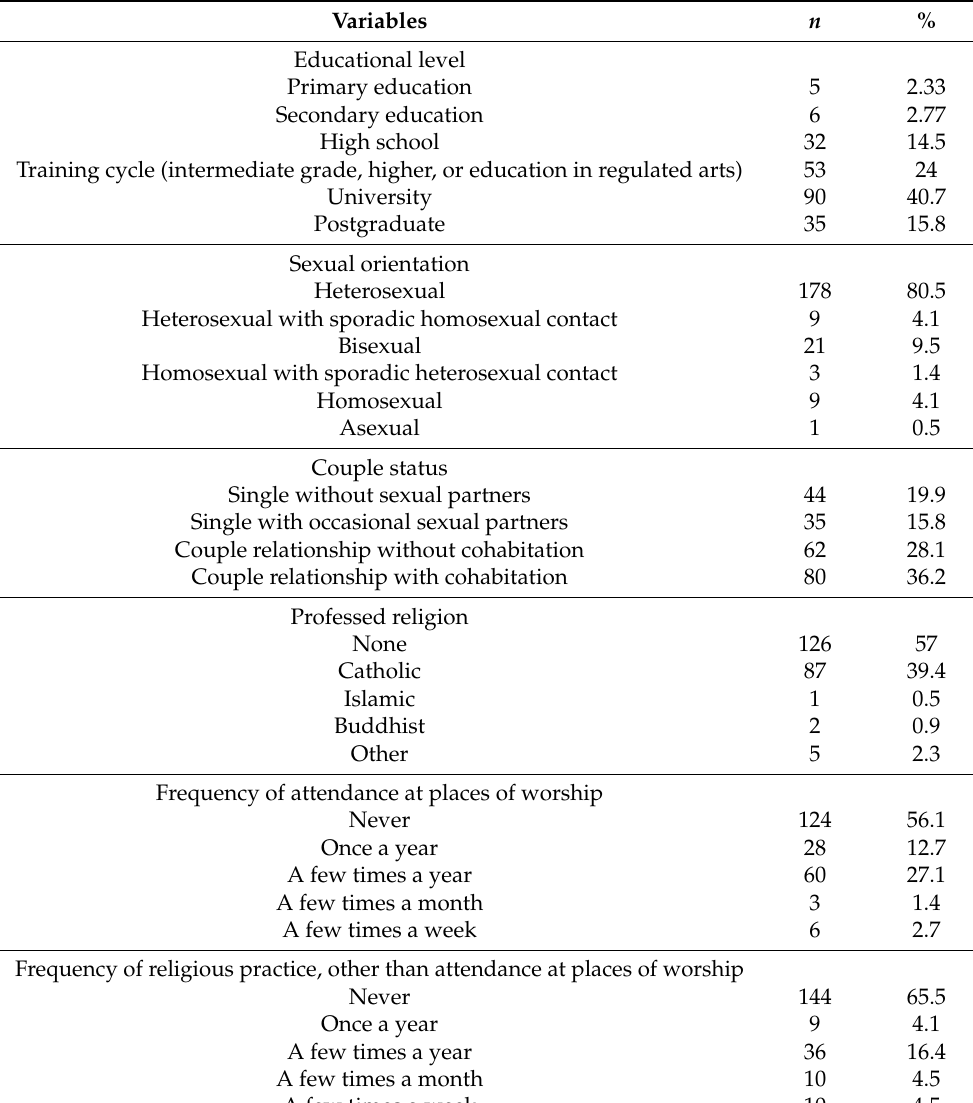
Table 1. Sociodemographic